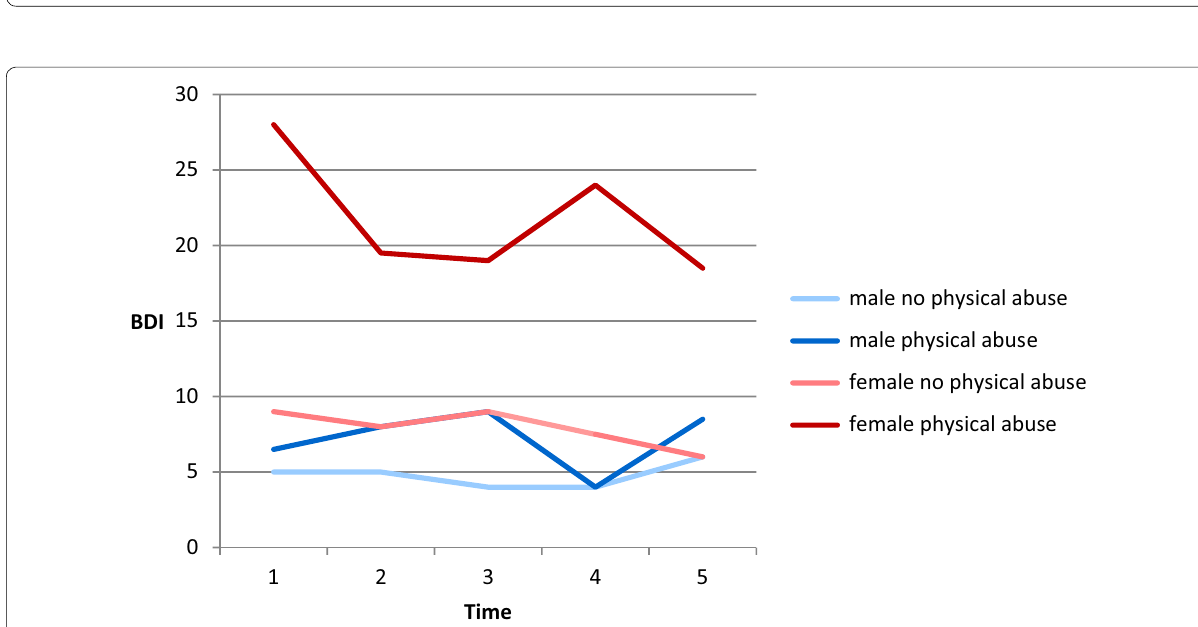
Fig. 1 Course of depressive symptoms from Time 1 to Time 5 for men and women with and without experiences of emotional abuse. BDI Beck Depression Inventory